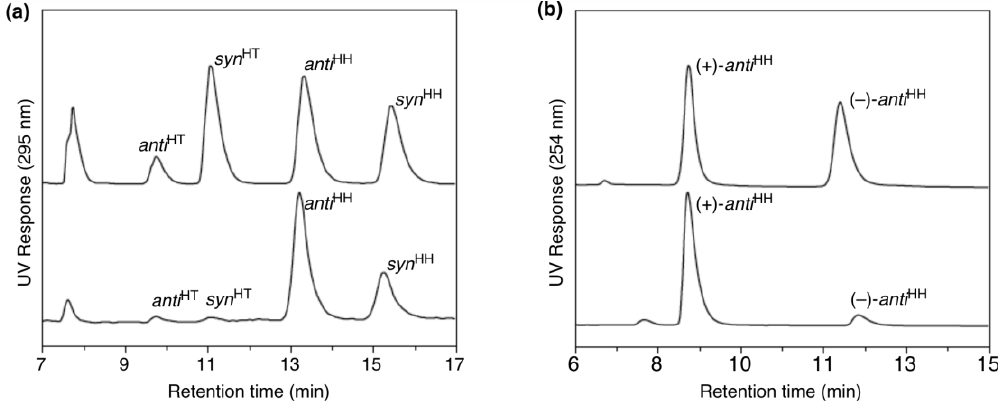
Figure 12. HPLC estimation of the isomer distribution of the photodimer esters 28 . ( a ) An authentic mixture of the four isomers of 28 (top) and a mixture obtained from photo-irradiated 27c ·(1 S ,2 S )- 26 (bottom). ( b ) An authentic racemate of anti HH - 28 (top) and anti HH - 28 obtained from photo-irradiated 27c ·(1 S ,2 S )- 26